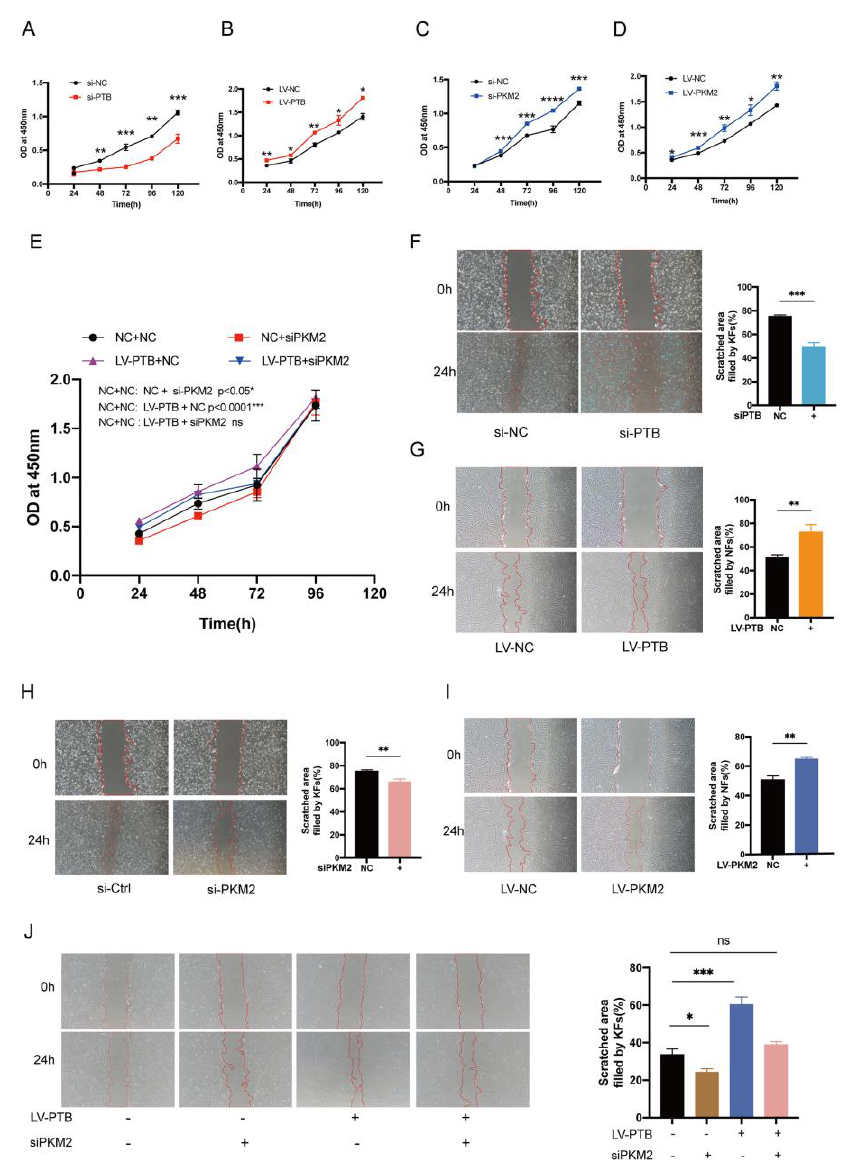
Figure 7. PKM2 knockdown abolished the PTB-induced proliferation and migration of fibroblasts. ( A ) CCK8 assay evaluation of the influence of the knockdown of PTB on the proliferation of KFb. ( B ) PTB overexpression enhanced the proliferation of NFb. ( C ) CCK8 assay of the influence of the knockdown of PKM2 on the proliferation of KFb. ( D ) Overexpression of PKM2 enhanced the proliferation of NFb. ( E ) CCK8 assay of the influence of the knockdown of PKM2 on NFb overexpressing PTB ( n = 3). ( F ) Scratch-wound assay showing KFb transfected with si-NC migrating from the edges of scratches into vacant areas, with complete closure by Day 2, whereas KFb transfected with siPTB had slower cell growth and decreased migration, and vacant areas were not fully covered on Day 2. ( G ) Overexpression of PTB increased the migration capacity of NFb ( n = 3). ( H ) CCK8 assay of the influence of knocking down PKM2 on the proliferation of KFb. ( I ) Effect of the overexpression of PKM2 on the proliferation of NFb. ( J ) PKM2 siRNA and PTB-overexpressing lentivirus were both transfected into NFb, and then the scratch wound assay was carried out ( n = 3). Data are presented